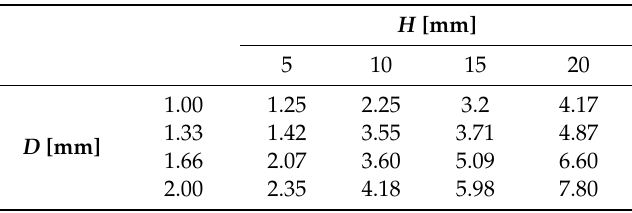
Table 3. Mass of spatial reinforcing